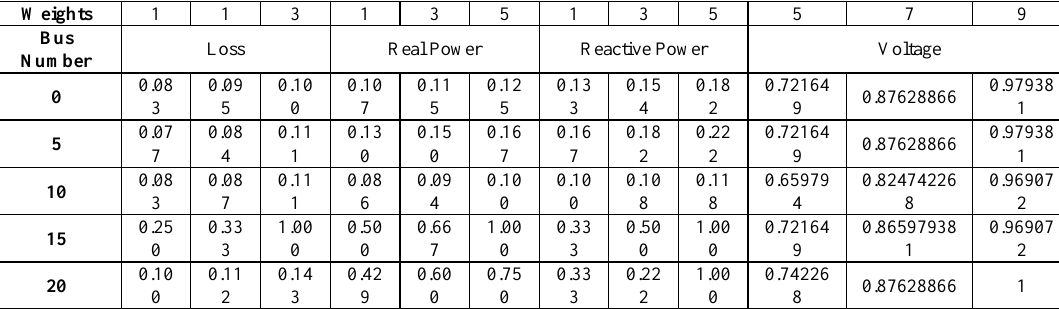
Table 10. Normalized fuzzy decision matrix.